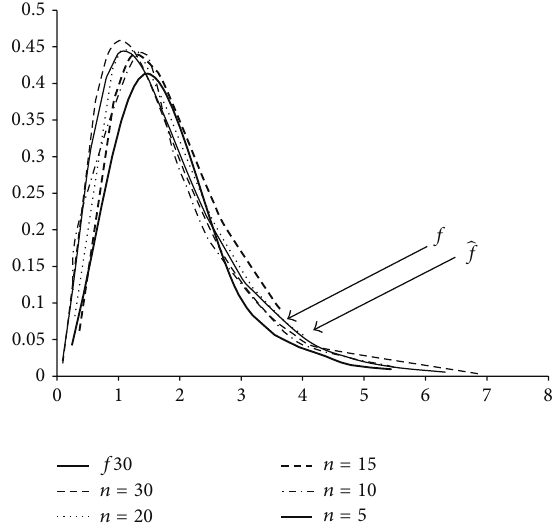
̂𝑓(𝑥; 𝛼,𝜆) and 𝑓(𝑥;𝛼,𝜆)